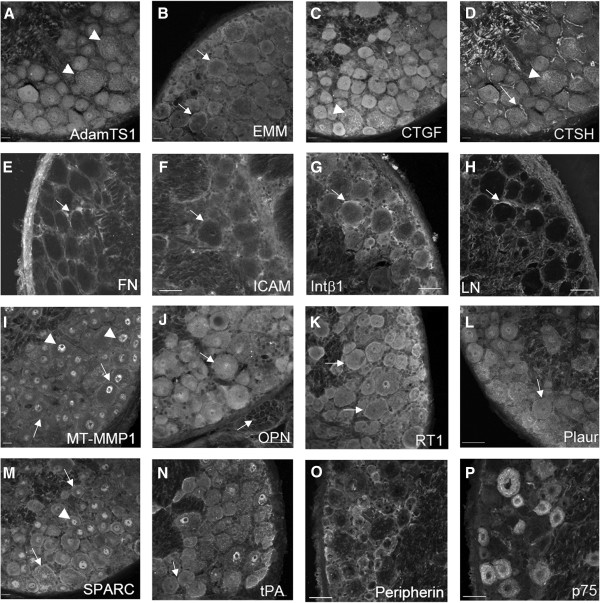
Immunohistochemisty of selected proteins in adult rat DRG cryosections. IHC and confocal microscopy was used to investigate expression of proteins encoded by a number of genes noted to be expressed at robust levels in the dissociated neurons, including those that have not been previously described in DRG neurons. Panels A – AdamTs1; B - Emmprin (Basigin); C – CTGF; D – CTSH; E - Fibronectin; F – Icam; G – Integrin β1; H – Laminin; I – MT-MMP1 (MMP19); J – Osteopontin (Spp1); K – RT-1 (RT-AWs); L – Plaur; M – SPARC; N – tPA (Plat); O – Peripherin; P – p75 neurotrophin receptor. Scale bar – 50 μm.